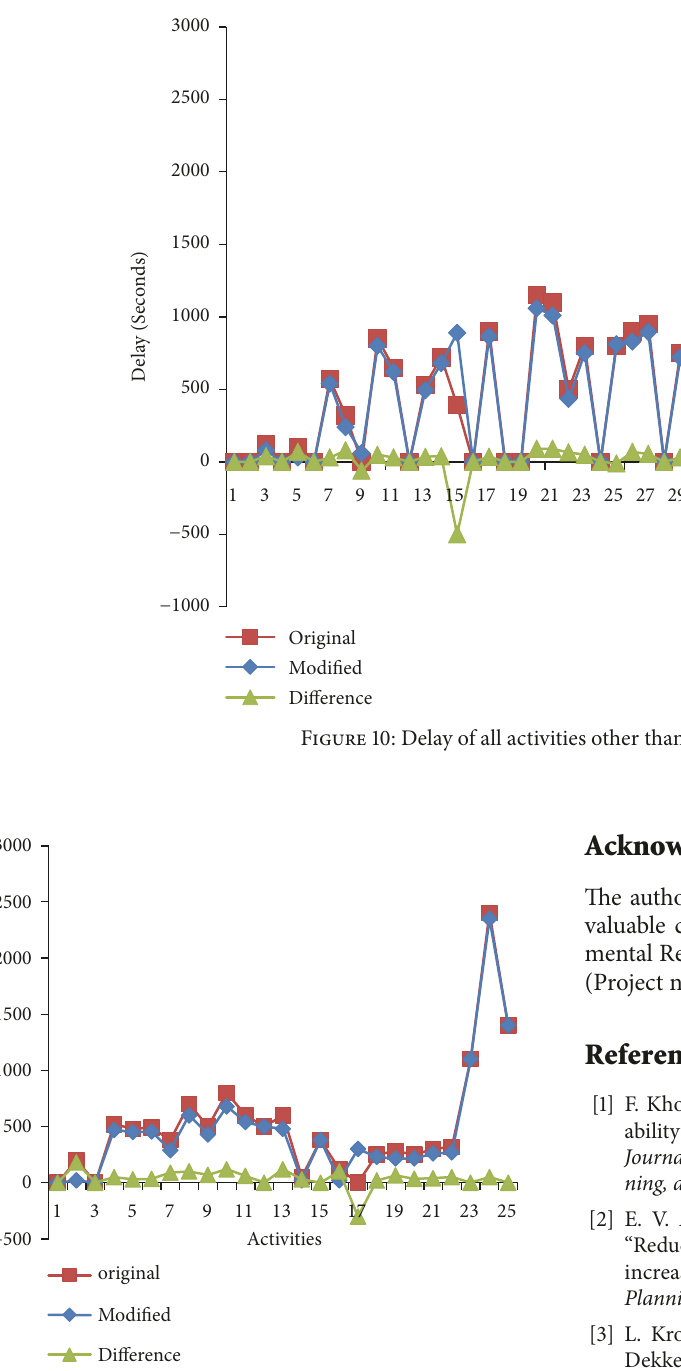
Figure 11: Delays of all activities composing the critical